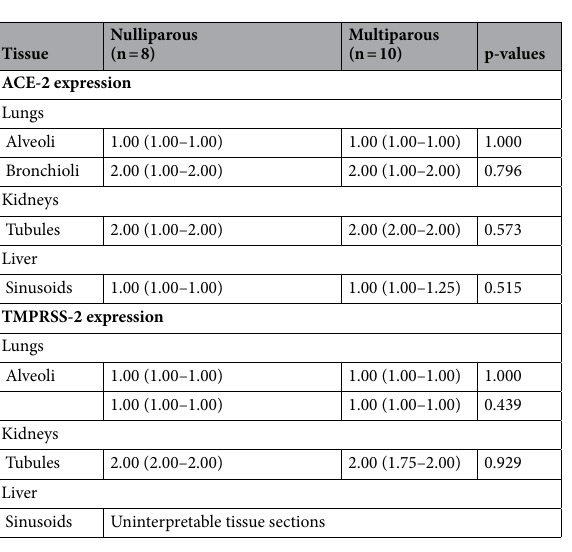
Table 3. Impact of female reproductive history on ACE-2 and TMPRSS-2 expression. Data are expressed as median (interquartile range). P-values were derived from Mann–Whitney test. ACE-2, angiotensin-converting enzyme 2; TMPRSS-2, transmembrane protease serine